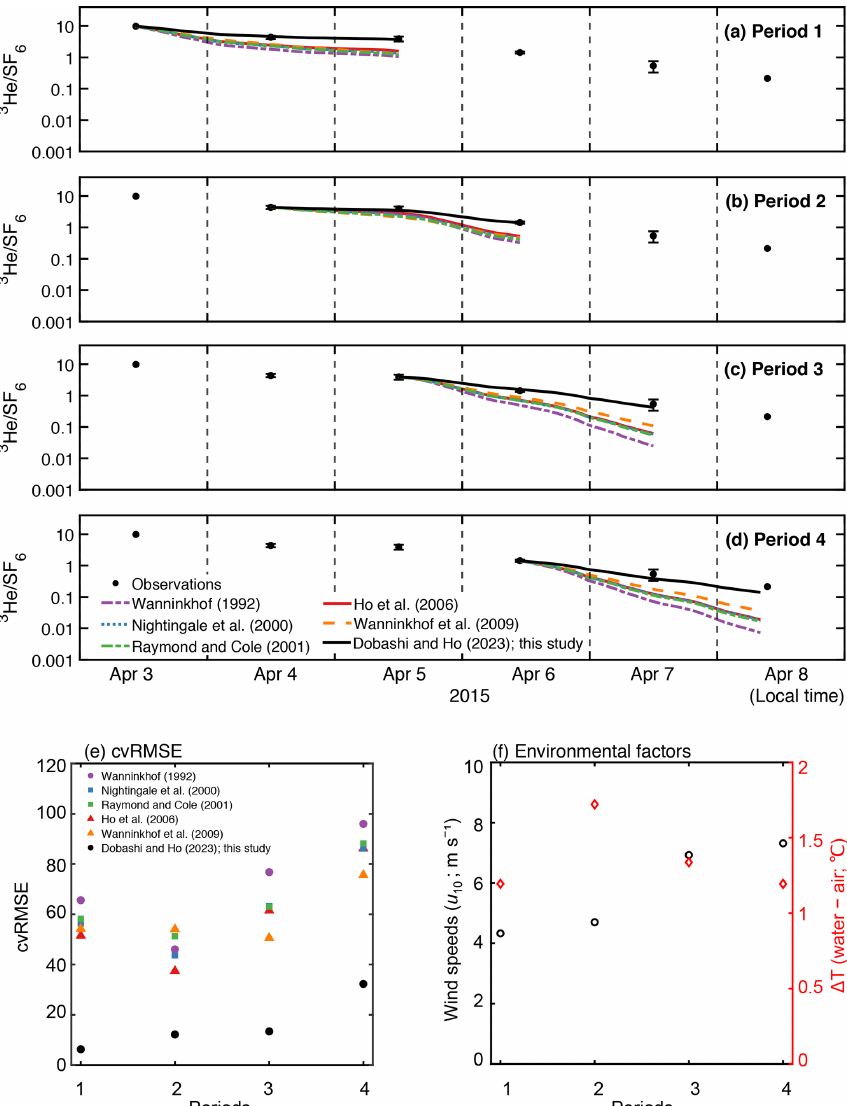
Figure 5. Time series of measured and modeled change in 3 He / SF 6 in (a) period 1, (b) period 2, (c) period 3, and (d) period 4 in Fig. 2f. The 3 He / SF 6 value is set to the starting point of each period. (e) The cvRMSE, (f) mean wind speed (ms ( ◦ C) during the periods 1–4. The x axis represents the periods in Fig.